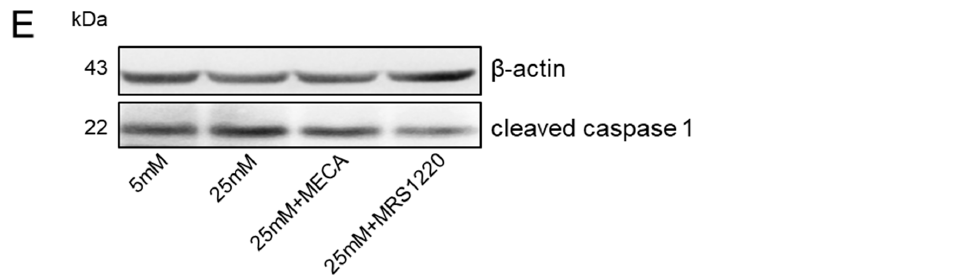
Figure 4. The ADORA3 antagonist reverses caspase 1 activation in diabetic rats in vivo and in cells in vitro . The levels of cleaved caspase 1 in the kidney sections from experimental group were assayed by immunohistochemistry. Representative images of cleaved caspase 1 distribution in kidney cortex are shown in ( A ) using MRS1220 as antagonist. Original magnification 400 × . The graph in ( B ) depicts the quantitative analysis of caspase 1 staining on 10 microscopic fields per slice from animals belonging to each experimental group using the UN-SCANIT 2.0 software. n = 5 in each group. *, p < 0.05 vs. control group; # , p < 0.05 vs. Diabetic group. In ( C ) is shown the enrichment of aquaporin1 (AQP1), a marker of proximal tubules, in the fraction of tubules purified from kidney cortex. The western blot shown in ( D ) indicates the reversion of the increases of cleaved caspase 1 in the proximal tubules-enriched fraction from diabetic rats treated with the antagonist of ADORA3. β -actin was used as loading control. The in vitro effects of ADORA3 modulation in HK2 cells is shown in ( E ). The western blot shows the attenuation of activated caspase 1 by the ADORA3 antagonist MRS1220 in HK2 cells exposed to high D -glucose concentrations of 25 mM.